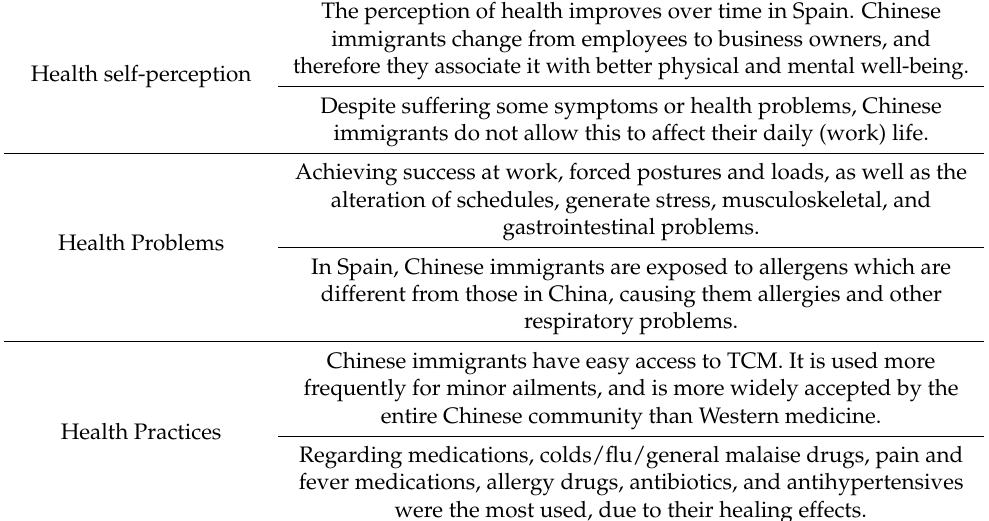
Table 5. Summary table of the